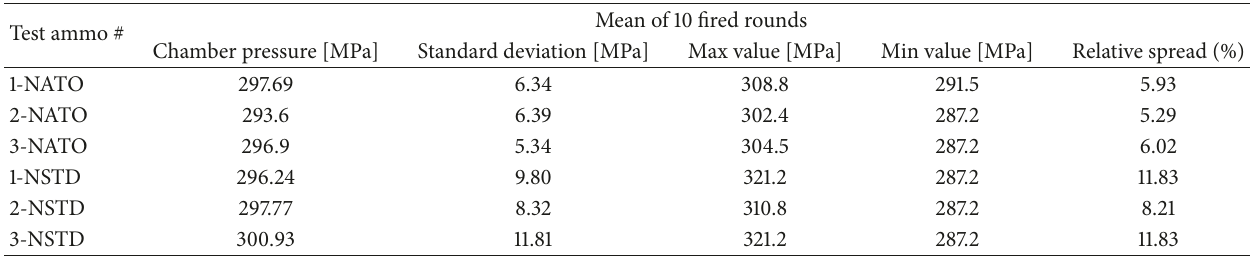
Table 4: Standard deviation and relative spread using copper crusher method at 25 mm.